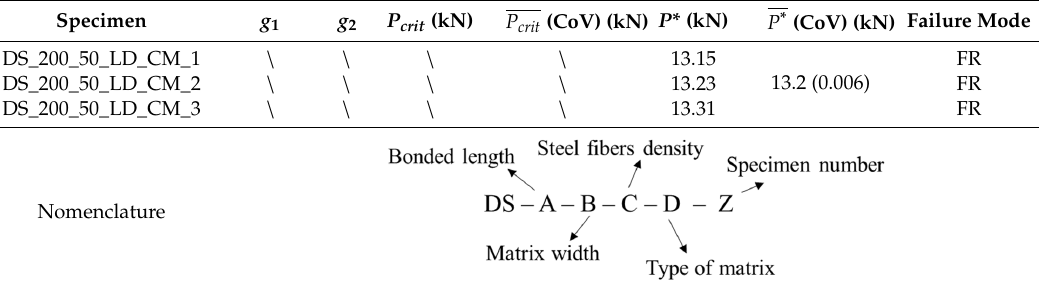
Figure 4. Single-lap direct shear set-up: ( a ) sketch of the test set-up; ( b ) photo of specimen with 50 mm; ( c ) 70 mm; and ( d ) 90 mm matrix width. Table 4. Test results of steel-reinforced grout (SRG)-concrete joints [43].